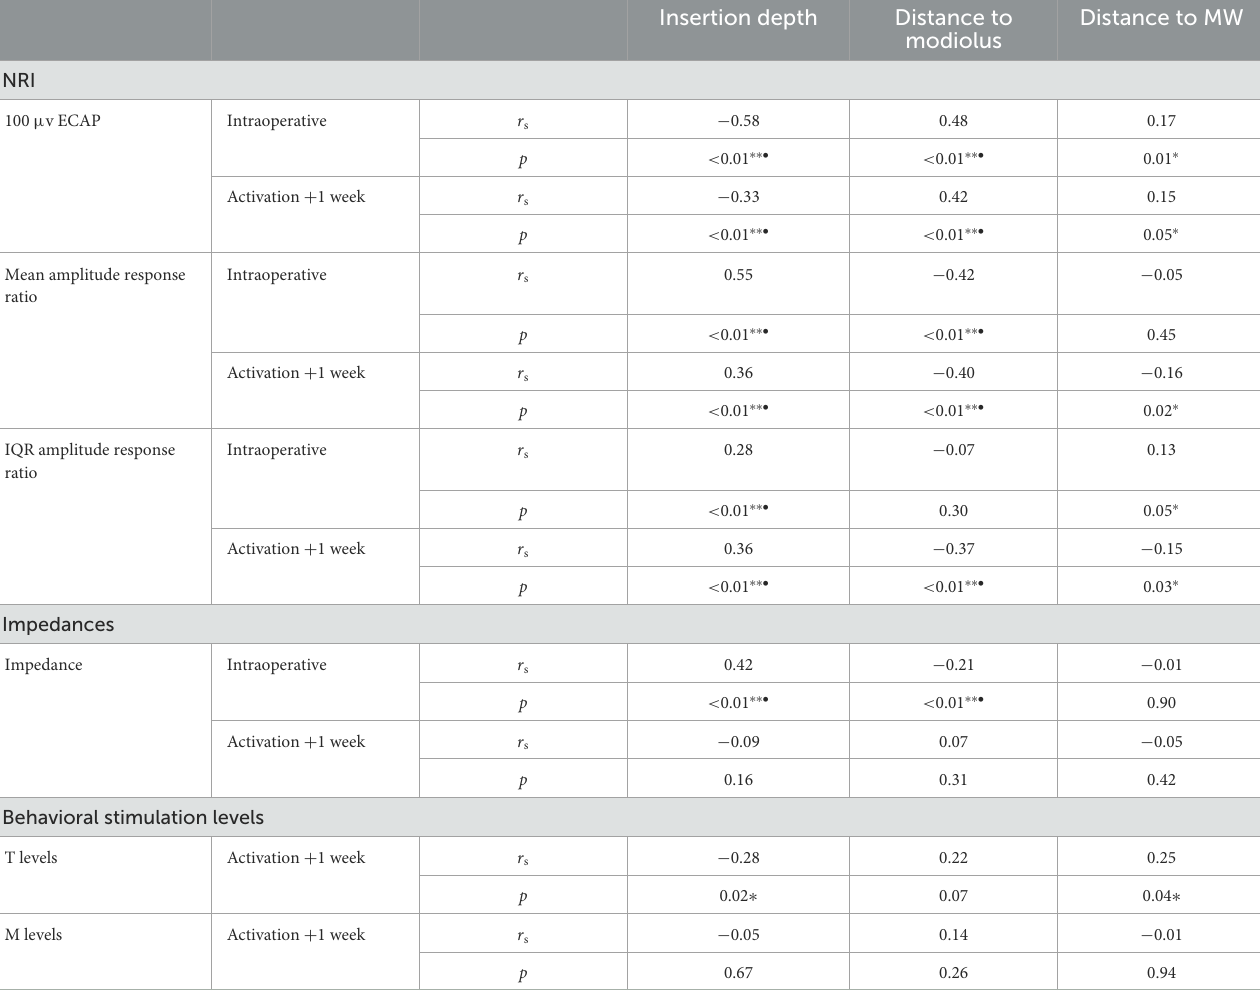
TABLE 3 Spearman correlation analysis showing relationships between electrode positioning and ECAP measures, impedances, and behavioral stimulation